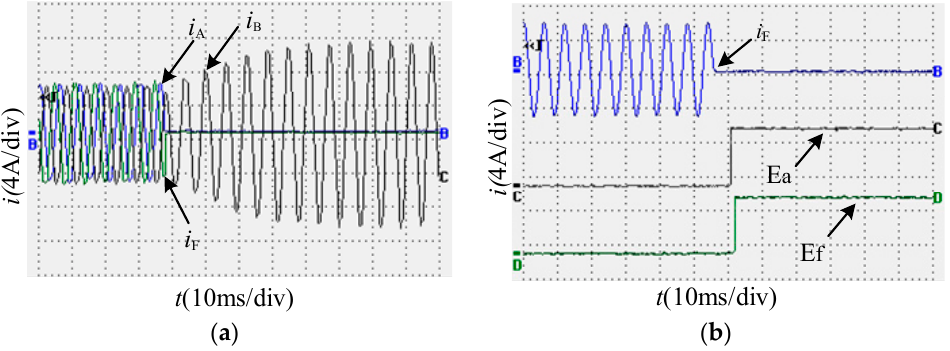
Figure 32. Phase current and fault index waveform in case of phase failure of phase a and phase f : ( a ) fault current waveform; ( b ) fault phase current and fault index waveform.